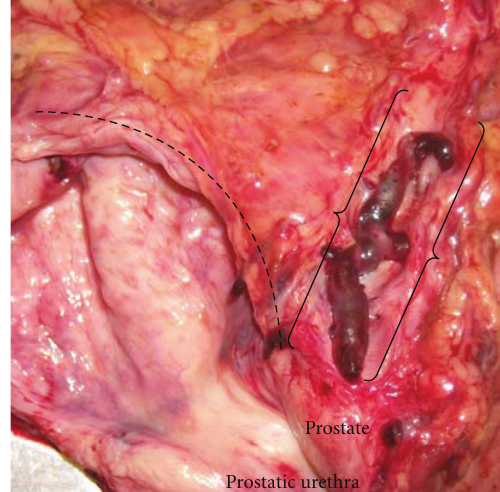
Figure 1: The bladder (dashed line) is open and a dissected peripro- static vein (between brackets) containing a large clot extending into the branches is seen on the right.